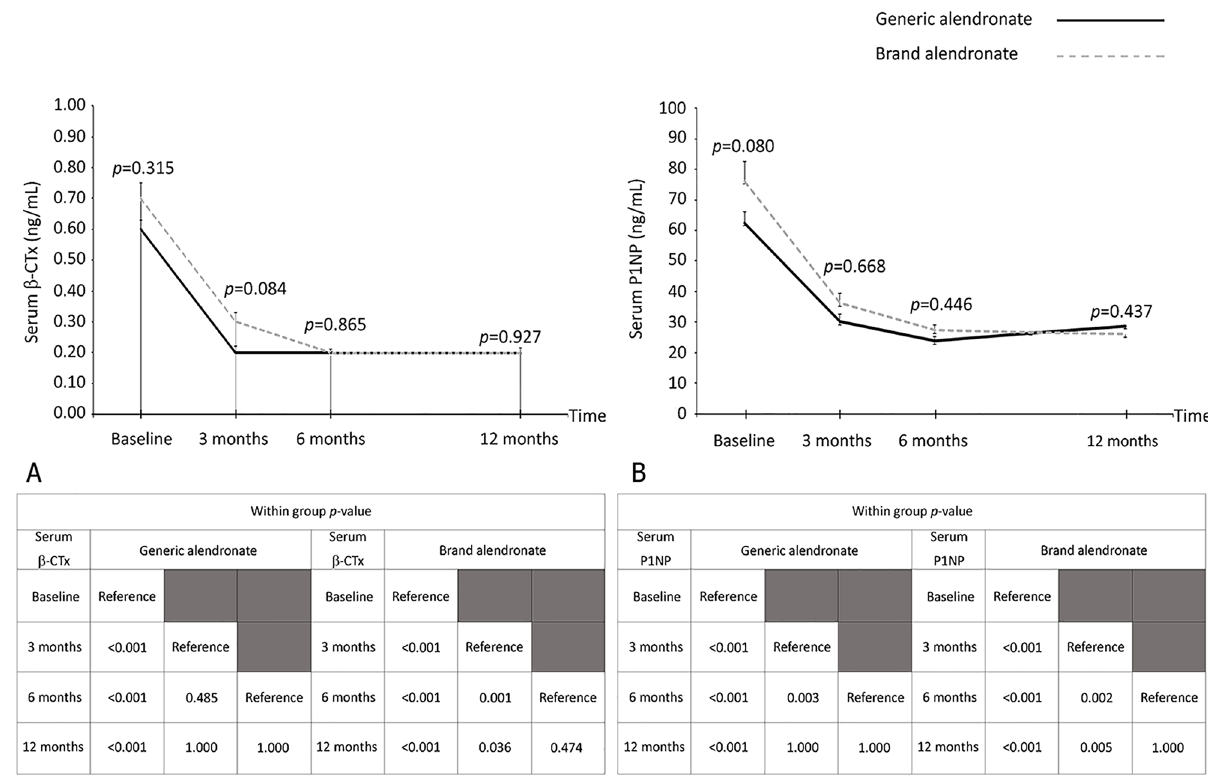
Fig 3. Mean values of biochemical bone markers, and within group and between group p -values. (A) serum β -isomerized C-terminal telopeptide( β -CTx); and, (B) serum total procollagentype 1 amino-terminal propeptide (P1NP) for the generic and brand alendronate patient groups before treatment (baseline) and at 3, 6, and 12 months after treatment. The error bars indicatestandard error. The p -values in the graphs comparelevels betweenthe generic and brand alendronatepatient groups, whilewithin group p -values are shown in the correspondingtable beloweach graph ( p -value < 0.05 indicatesstatistical